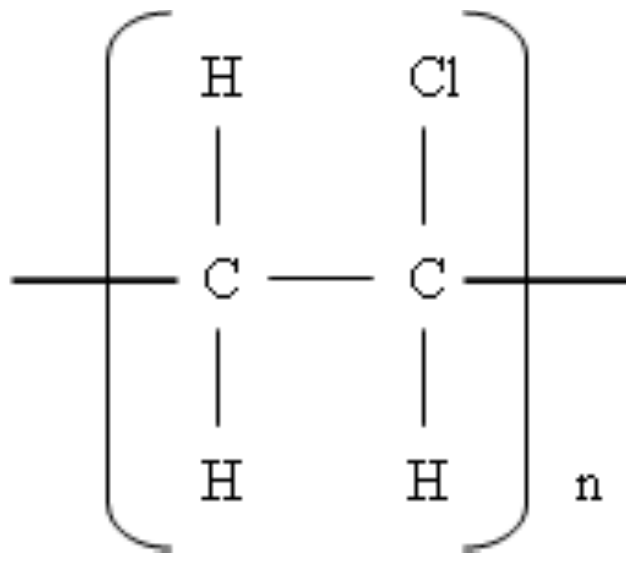
Figure 6. Poly(vinyl chloride) (PVC) structure.